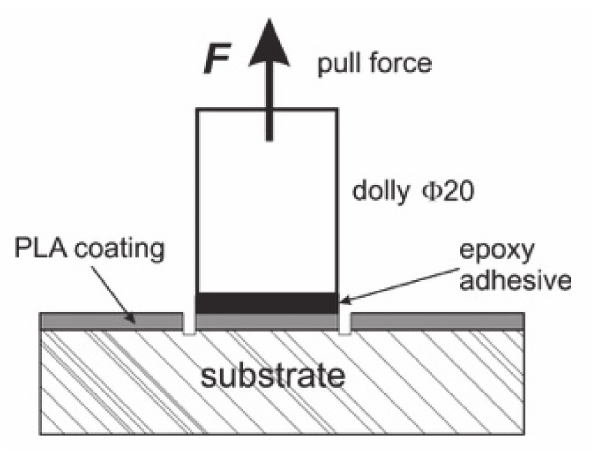
Figure 2. Pull-off